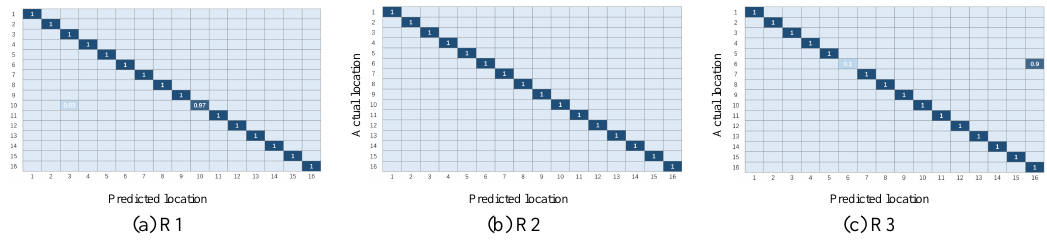
Figure 8. Confusion matrix under different multi-domain representations ( T 2 - T 1